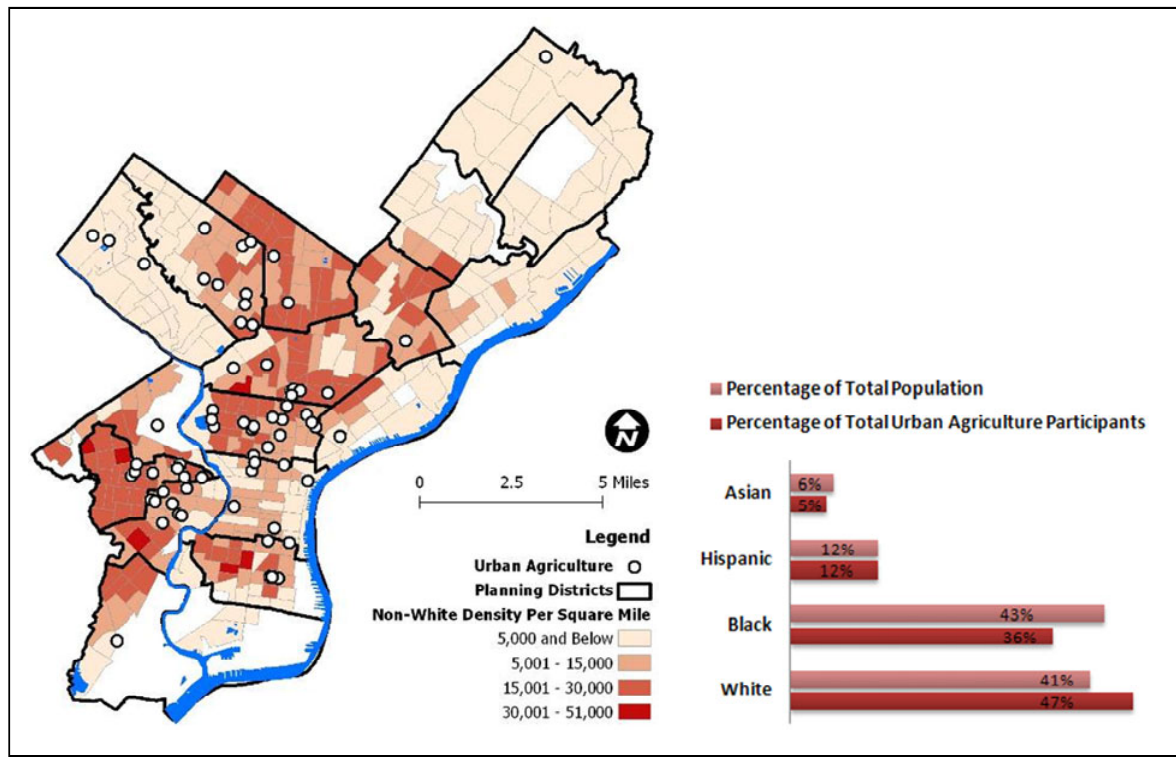
Figure 3. Comparison of the Racial Profiles of City Residents and Urban Agriculture Participants